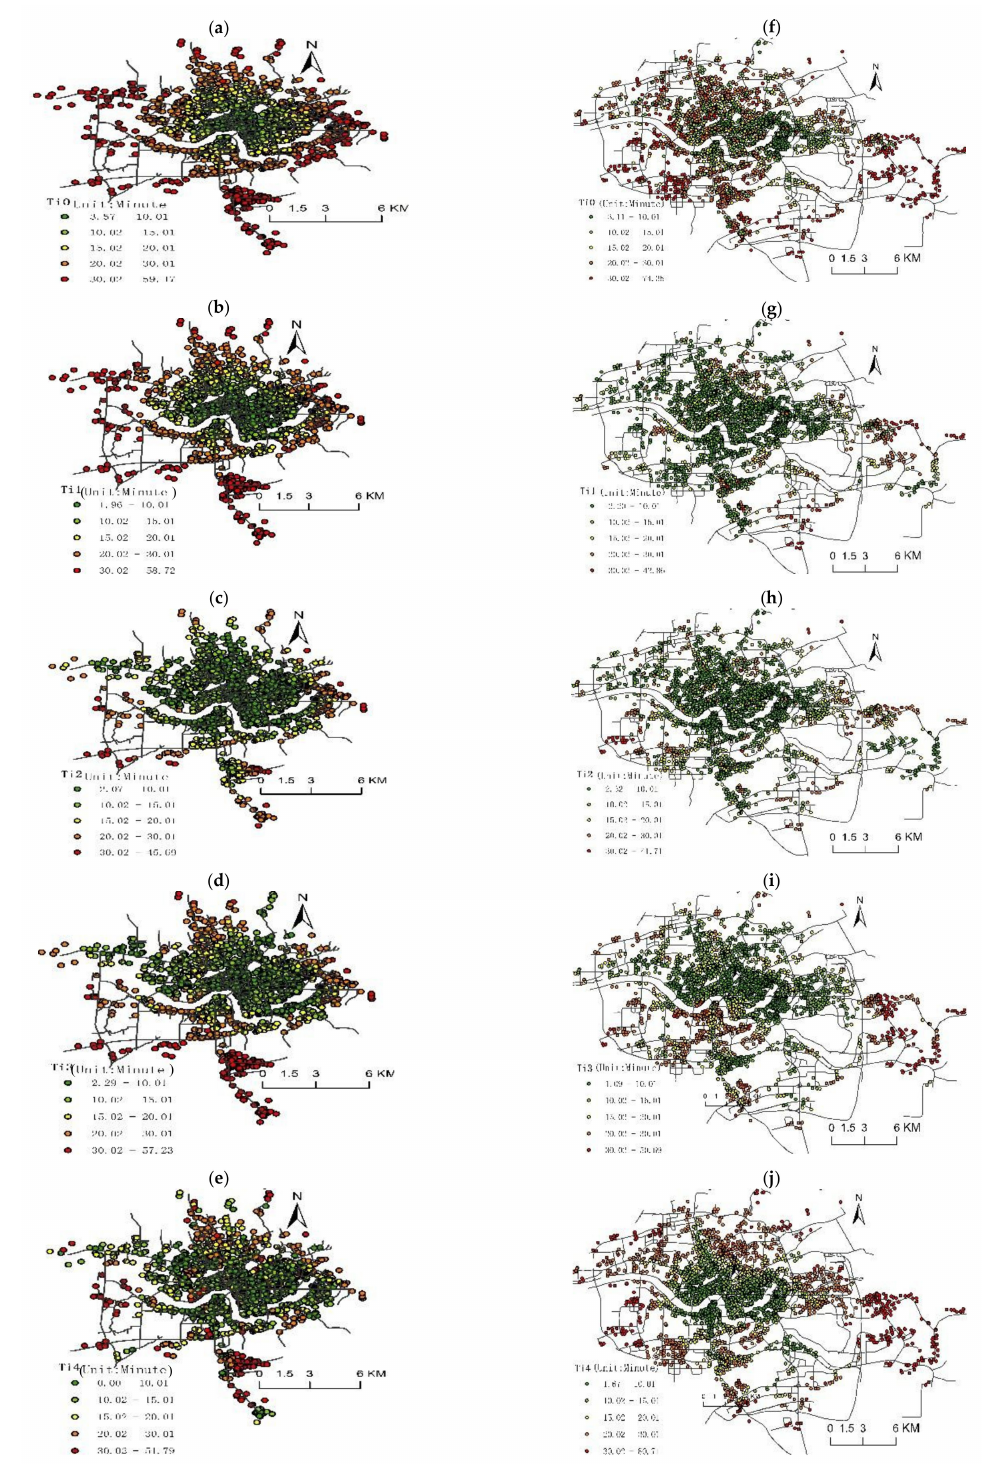
Figure 5. RCs distribution according to travel Time to different types of destinations in 2000 and 2020 (with subway) (unit: minute). Total Time to City Center in 2000 ( a ); Total Time to shopping in 2000 ( b ); Total Time to the Hospital in 2000 ( c ); Total Time to the Park in 2000 ( d ); Total Time to the Culture Facilities in 2000 ( e ); Total Time to City Center in 2020 ( f ); Total Time to shopping in 2020 ( g ); Total Time to the Hospital in 2020 ( h ); Total Time to the Park in 2020 ( i ); Total Time to the Culture Facilities in 2020 ( j